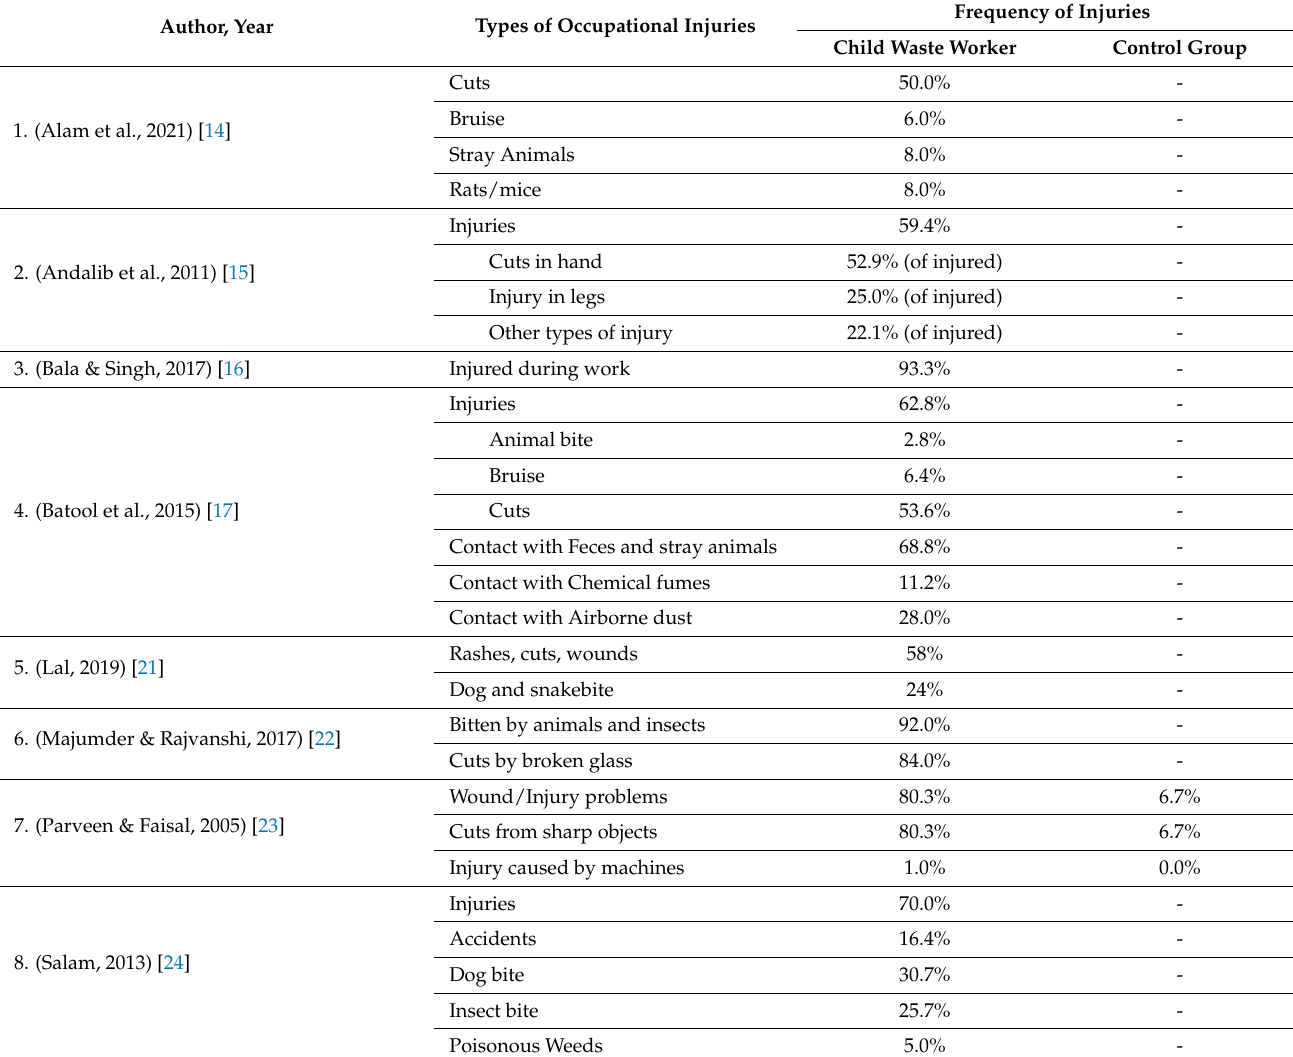
Table 4. Occupational injuries among child waste